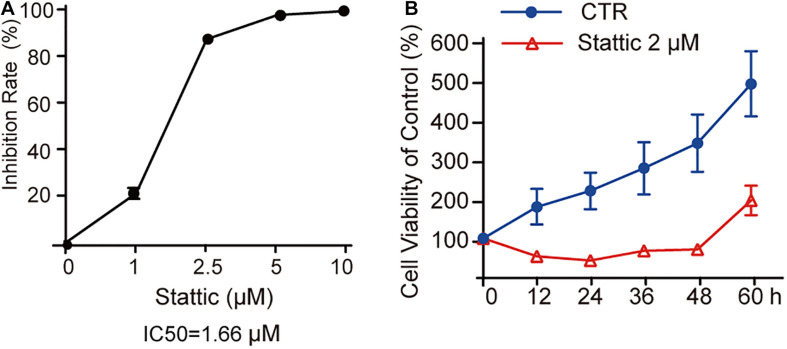
Stattic inhibits the proliferation of MV4-11 cells in a dose-and time-dependent manner. Stattic inhibits the growth of MV4-11 cells. The cell proliferation inhibition induced by Stattic in MV4-11 cells is time- and dose-dependent. (A) MV4-11 cells were treated with 0, 1, 2.5, 5, and 10 μM Stattic for 24 h (n = 3, IR of MV4-11 cells treated with 1, 2.5, 5, and 10 μM Stattic for 24 h were 21.00 ± 2.33%, 86.45 ± 0.58%, 96.76 ± 0.51%, and 98.54 ± 0.53%, respectively). (B) MV4-11 cells were treated with 2 μM Stattic or DMSO (as control) and cell viability was tested by CCK at 12, 24, 36, 48, and 60 h (n = 5, cell viability of DMSO group at 12, 24, 36, 48, and 60 h were 180.04 ± 44.39%, 219.92 ± 46.07%, 276.84 ± 65.26%, 340.23 ± 72.34%, and 489.21 ± 82.07%, respectively; cell viability of Stattic group at 12, 24, 36, 48, and 60 h were 54.85 ± 6.34%, 45.01 ± 3.49%, 68.66 ± 6.61%, 73.22 ± 4.76%, 196.21 ± 36.97%, respectively.